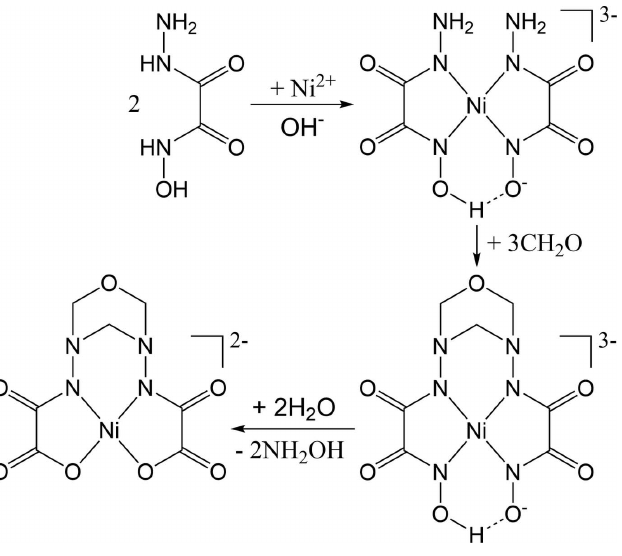
Figure 1 The plausible mechanism for the formation of the [Ni( L -2H)] 2–